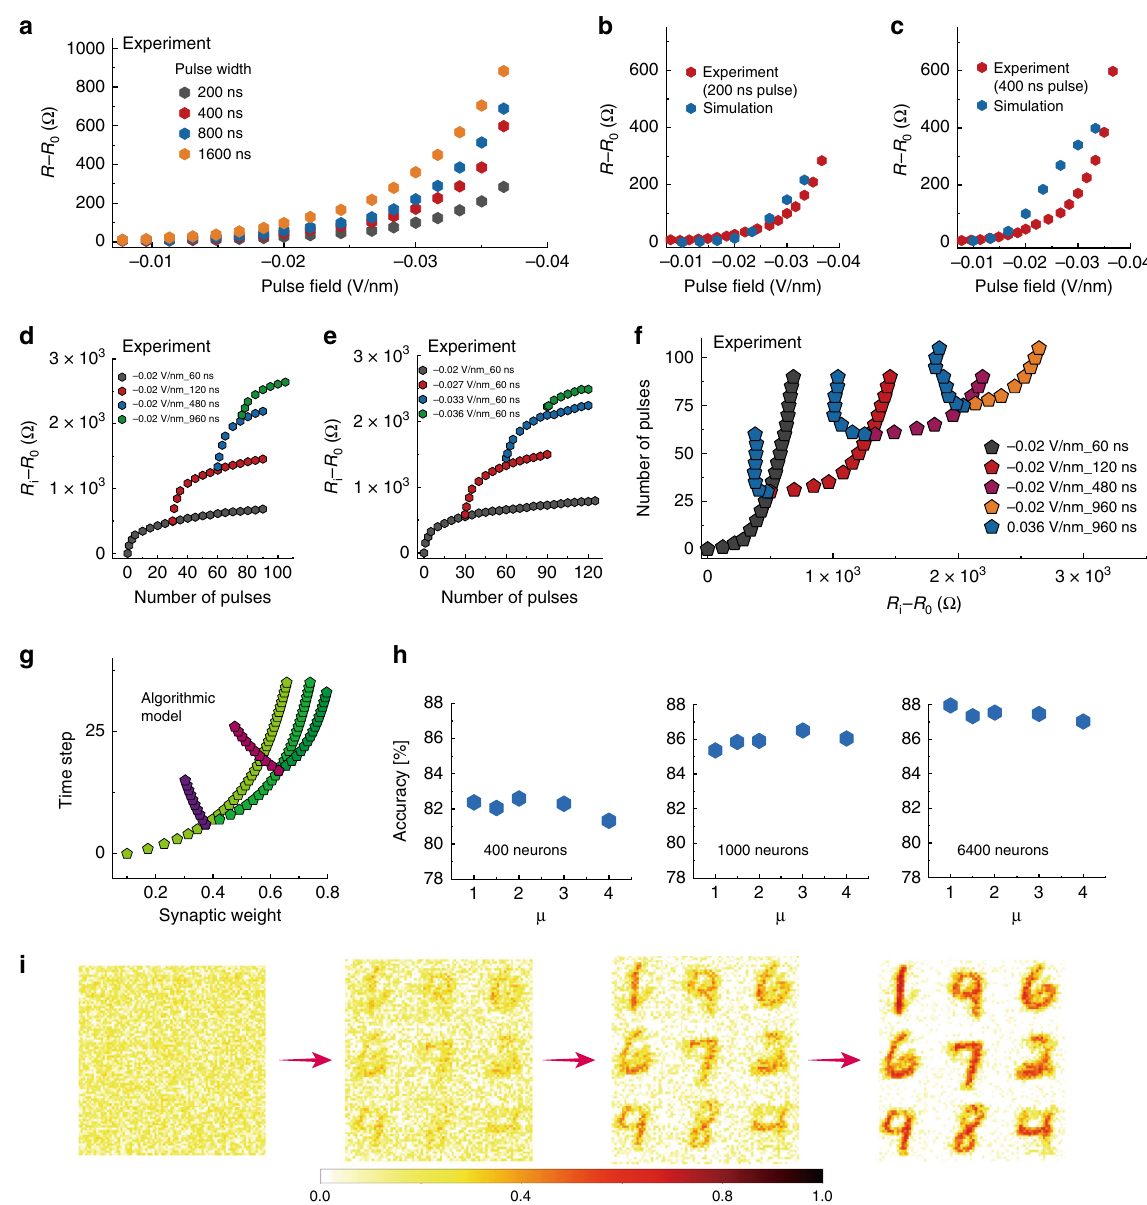
Fig. 2 Experimental data of electrical behavior and simulation in neural networks. a Change in electrical resistance of the nickelate device after voltage pulses were applied with different pulse fi eld and pulse width. The change in resistance is proportional to both the pulse fi eld and pulse width. b , c Modeling and experimental results of the change in resistance after application of various voltage pulses, b 200 ns pulse, and c 400ns pulse widths. d , e The electrical response of the nickelate device to consecutive electrical pulses. The different colors in ( d ) represent different pulse widths, while the different colors in ( e ) represent different pulse fi eld. The structure was generated following the method shown in Supplementary Fig. 6. f By applying consecutive positive or negative pulses, tree structure comprising different resistance states can be generated, with characteristics similar to synaptic behavior in the central nervous system 12,14 – 16 . The same colored data points correspond to a fi xed input that is applied to the device. g Algorithmic weight change as a function of learning time steps. The synaptic weight update mechanism has a tree structure that is inherently possessed by the nickelate devices (for μ = 3). h Object recognition testing accuracy of a spiking neural network on Modi fi ed National Institute of Standards and Technology database (MNIST) dataset when trained with different μ values on 400, 1000, and 6400 excitatory neurons. Testing accuracy change of about ±0.5% is observed, which does not signi fi cantly hamper the network ’ s digit recognition performance, hence the network is suf fi ciently immune to variations in μ . i Weight evolution of nine neurons when the spiking neural network is trained using spike time dependent plasticity (STDP) learning rule. The learning evolves such that the weights associated with each neuron approximates one of the variations of the digit learned by that neuron since each neuron in excitatory layer is connected to all neurons of the input